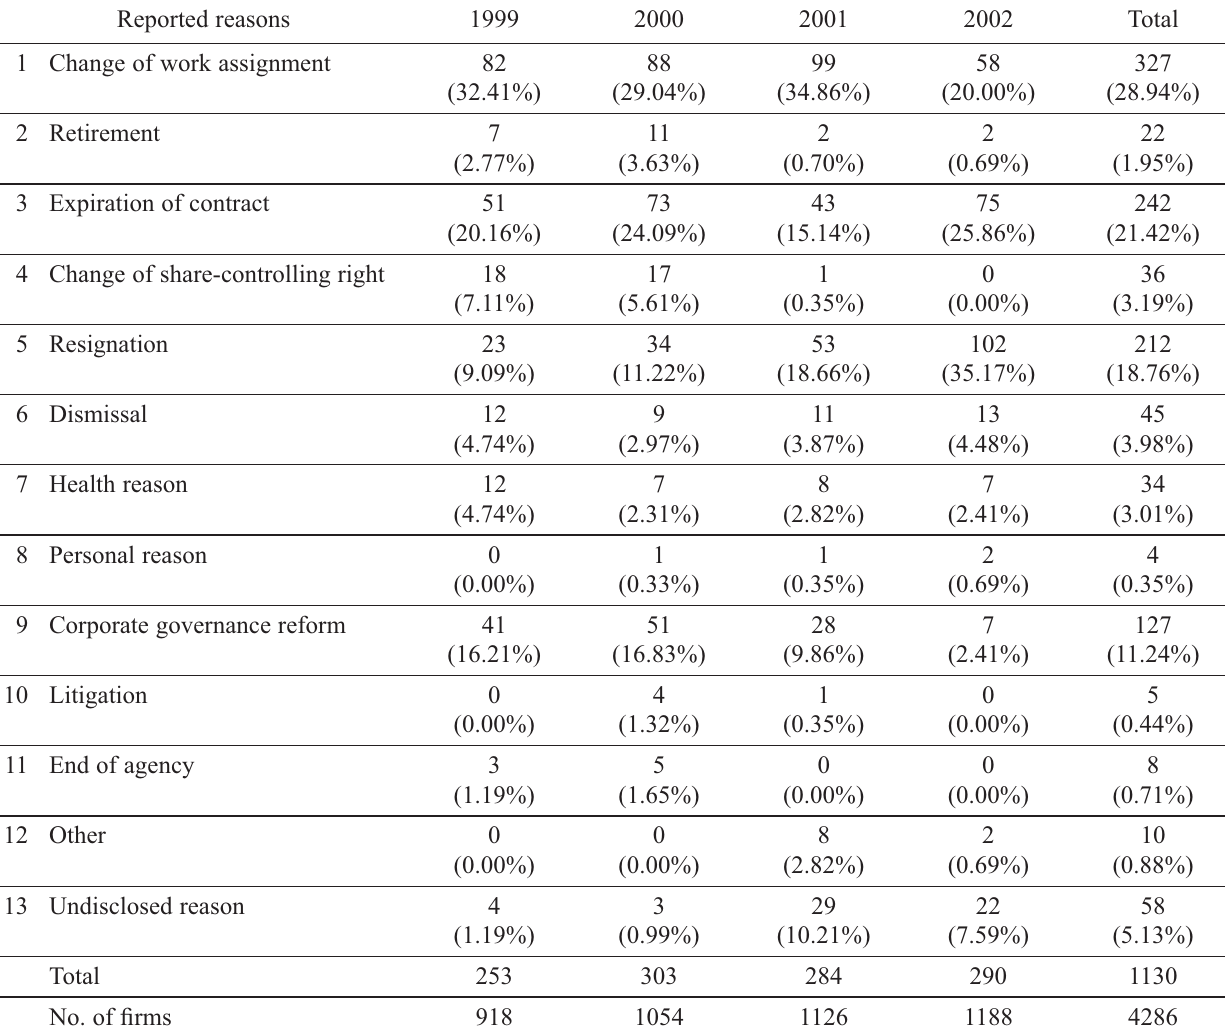
Table 3. Distribution of CEO turnovers among publicly listed fi rms in China during 1999–2002 The CSMAR (Chinese Stock Market and Accounting Research) database classifi es the reported reasons of CEO turnovers in China into 13 categories. There are 1130 CEO turnovers in our sample of 1203 fi rms during the period of 1999–2002. The table reports the frequency and percentage (in parentheses) distribution of CEO turnovers among the 13 categories of the reported reasons during each year and the entire sample